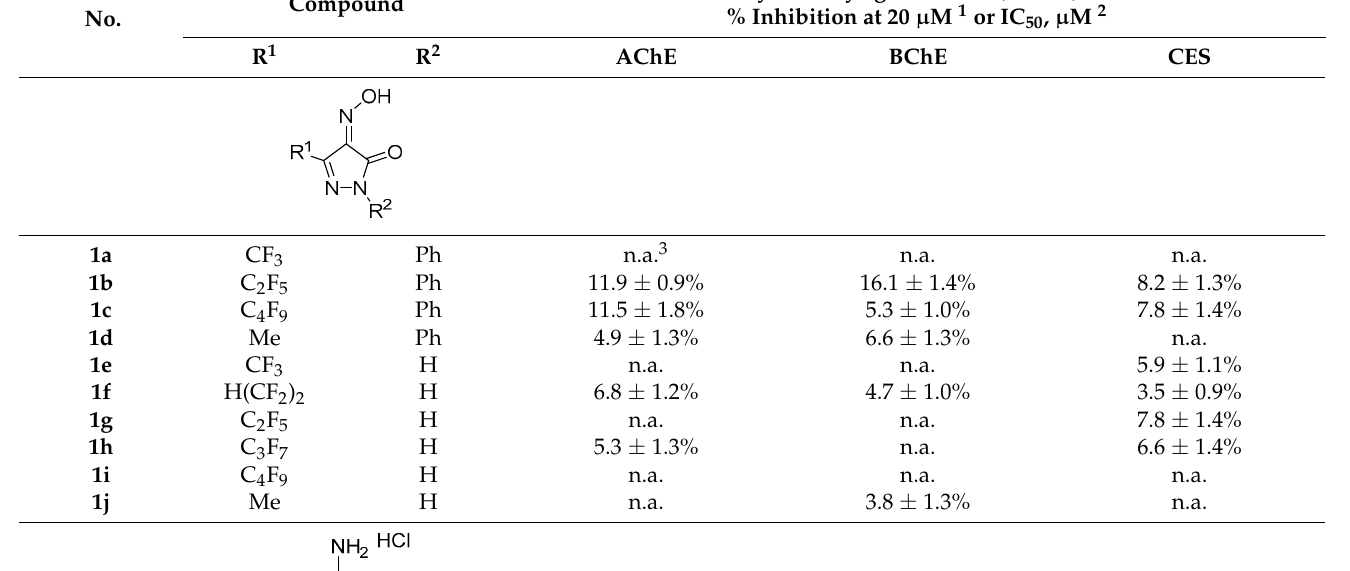
Table 2. Esterase profile of pyrazoles 1 and 4 .